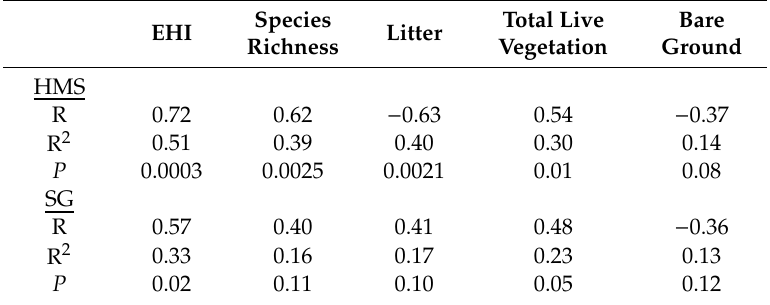
Table 4. Ecological health indicator (EHI) and quantifiable measurements (QM) correlated with carrying capacity in Humid Magellan Steppe (HMS) and Subandean Grasslands